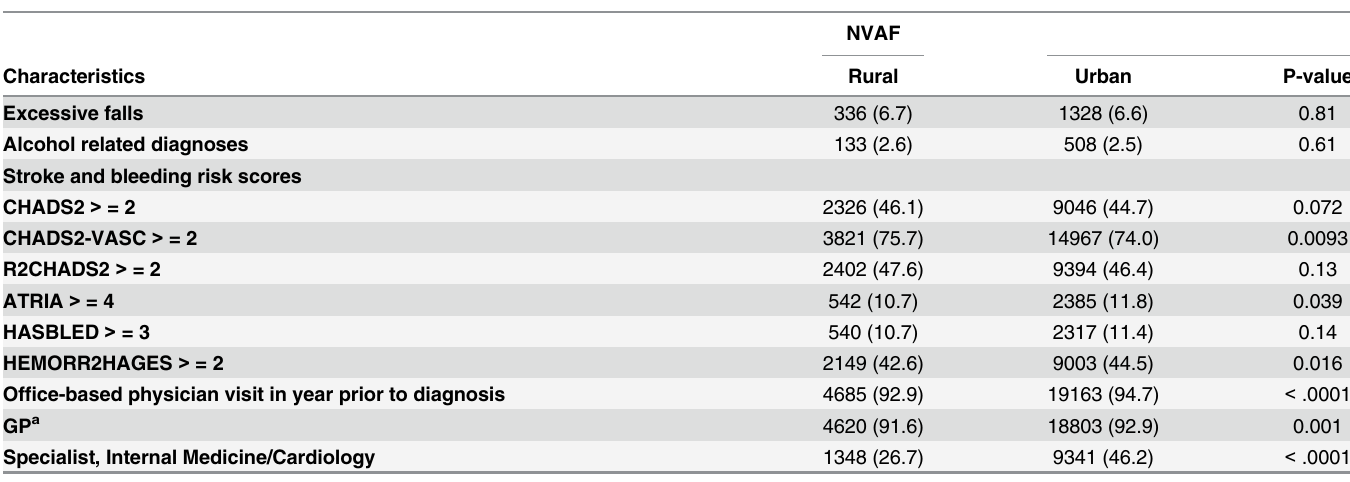
Table 1 legend a ED represents emergency department; TIA represents transient ischemic attack; GP represents general practitioner. Numbers are n (%) unless otherwise speci fi ed. P-values are calculated using Chi-Square test (proportion), t-test (mean), or Wilcoxin rank sum